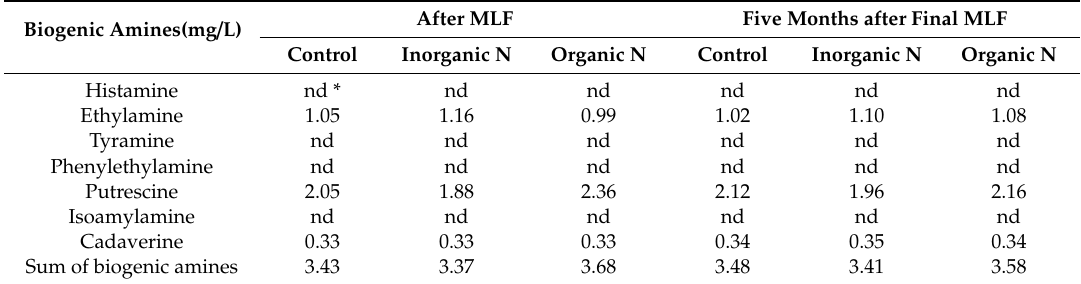
Table 4. Average values of biogenic amines content of wines after MLF and after 5 months of conservation with di ff erent nitrogen